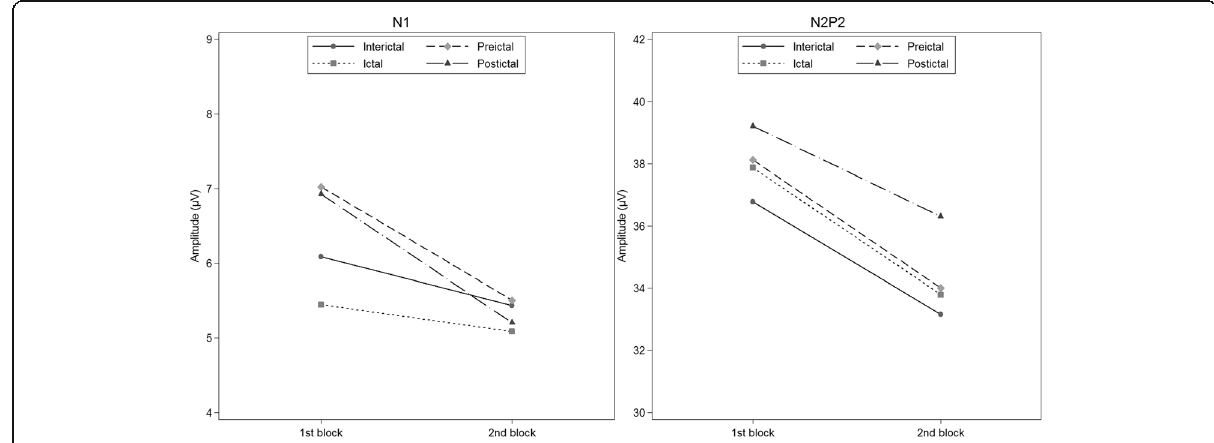
Fig. 3 Estimates of N1 (left) and N2P2-amplitude (right) habituation by phase